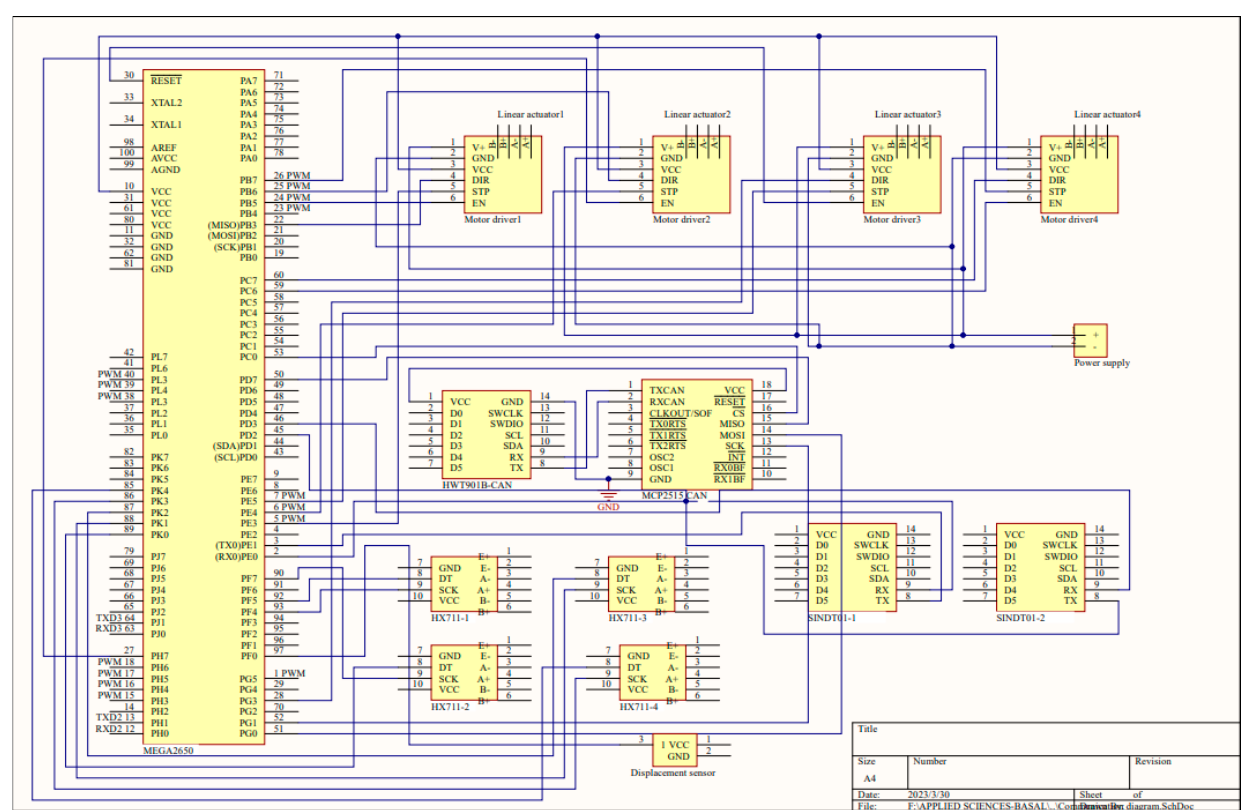
Figure 5. Communication diagram.